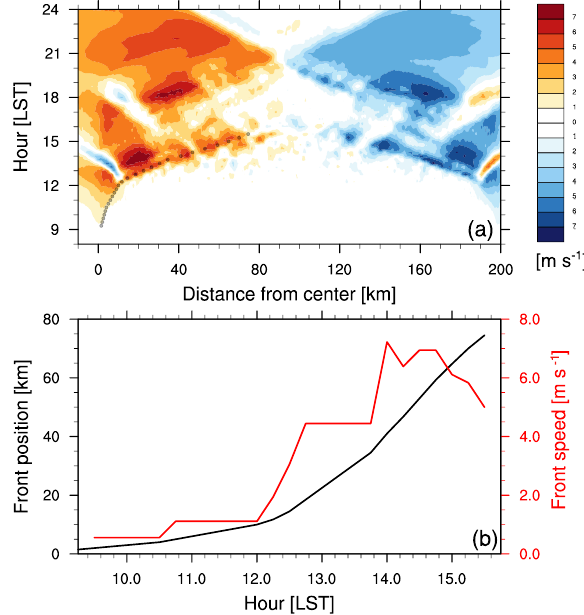
Figure 4. Tracking of the front associated with the mesoscale circu- lation for the case DA_20_100 . (a) Hovmöller diagram (distance from domain center vs. time) of the y -averaged zonal wind at a height of 150m above the surface. Dots indicate the position of the front tracked every 15min (see text for details). (b) Front in- land propagation (black line) with respect to the center of the do- main (km) and front speed (red line) derived using finite differences (ms − 1 ).